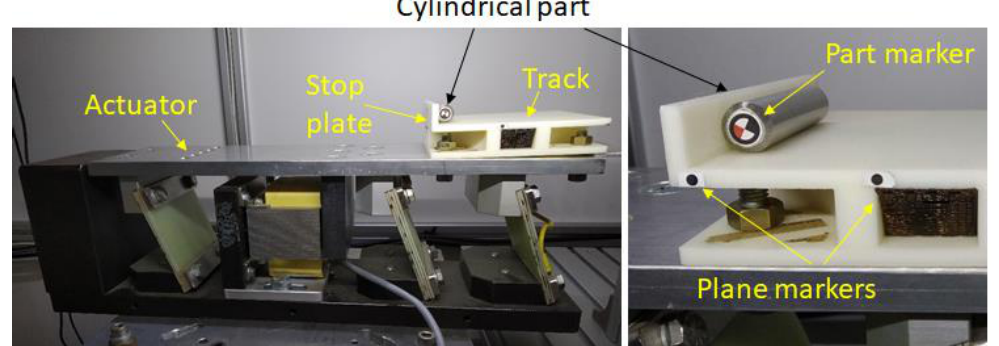
Figure 19. Vibratory conveyor for experimental tests.